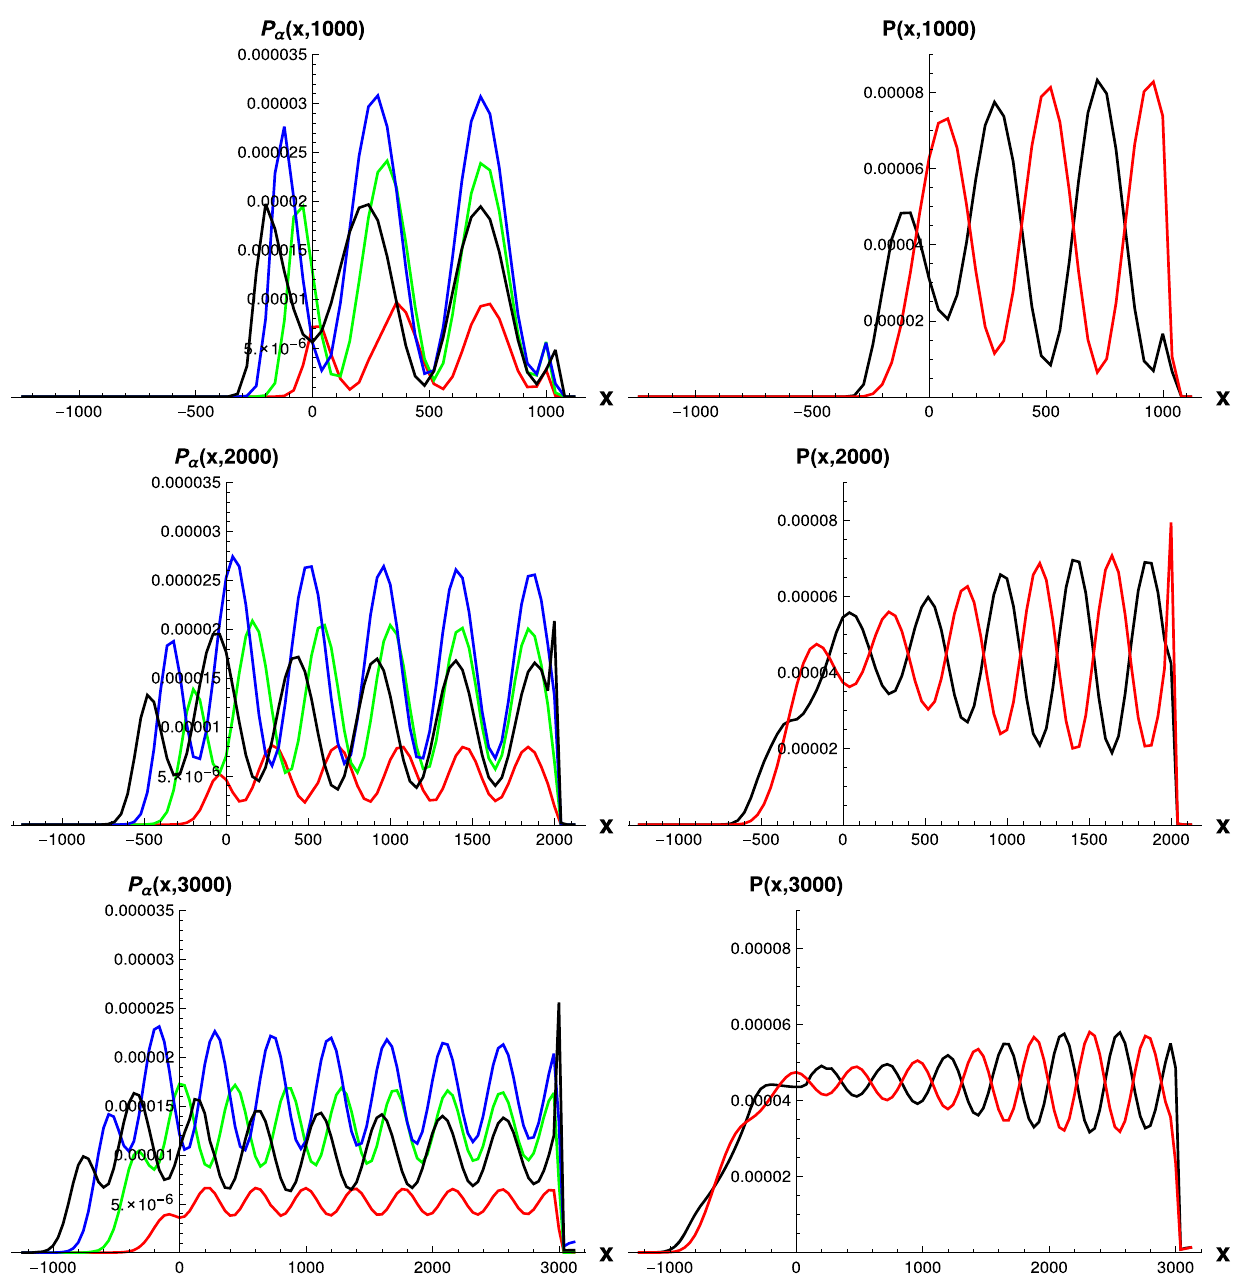
Fig. 9 The probability densities P (right, black) and the partial prob- ability densities P α (left) at t = 1000 (top), t = 2000 (middle) and t = 3000 (bottom). The red curve in the right panels is the appearance probability density P app . The environmental interaction energy eigen-